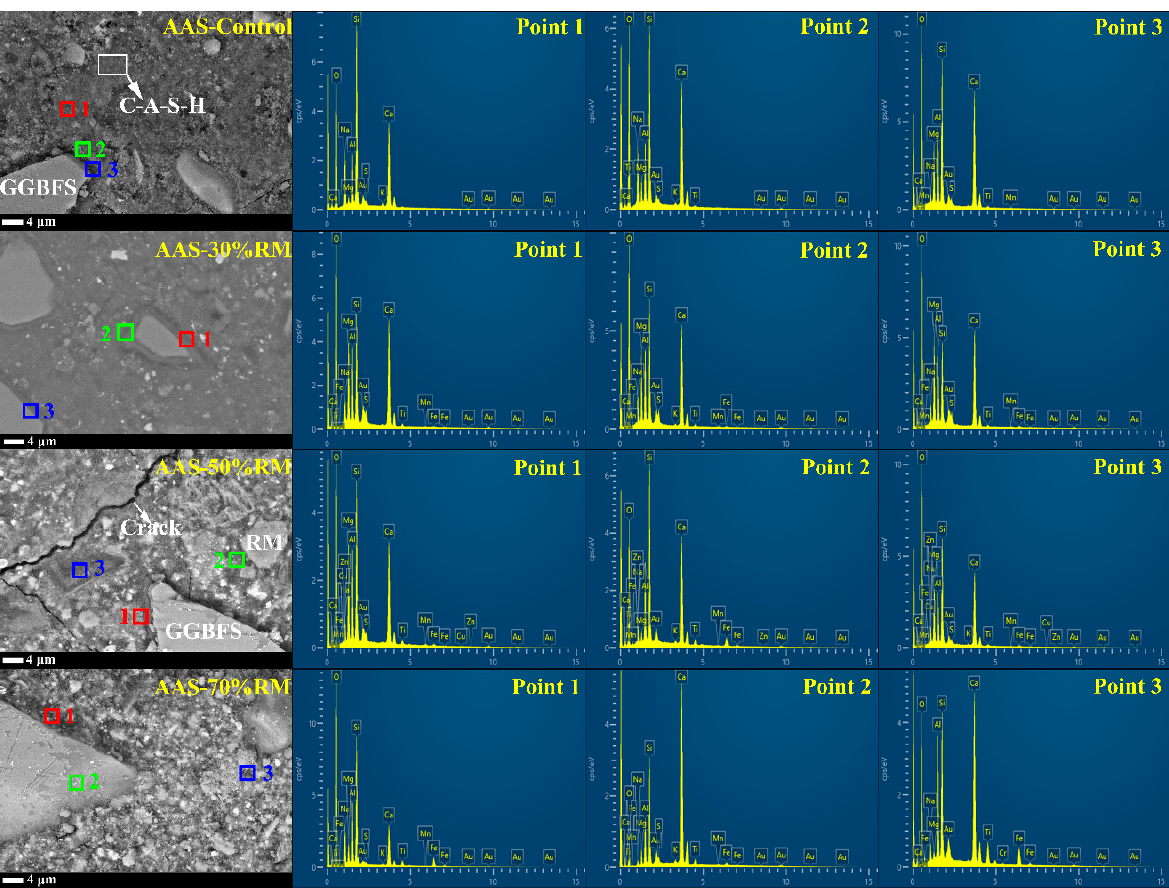
Figure 9. BSE/EDS images of alkali slag-red with different additions of RM.